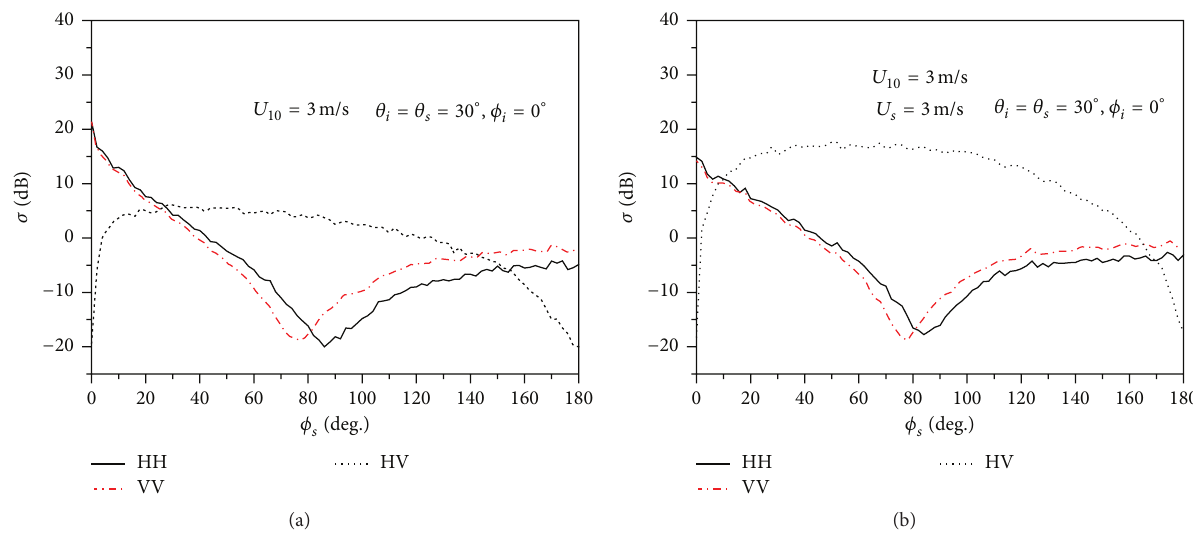
Figure 15: Bistatic scattering coefficient versus scattering azimuth angle 𝜙 𝑠 . (a) Sea surface alone at wind speed 𝑈 10 = 3 m/s and (b) sea surface with ship wake at wind speed 𝑈 10 = 3 m/s and ship speed 𝑈 𝑠 = 5 m/s.